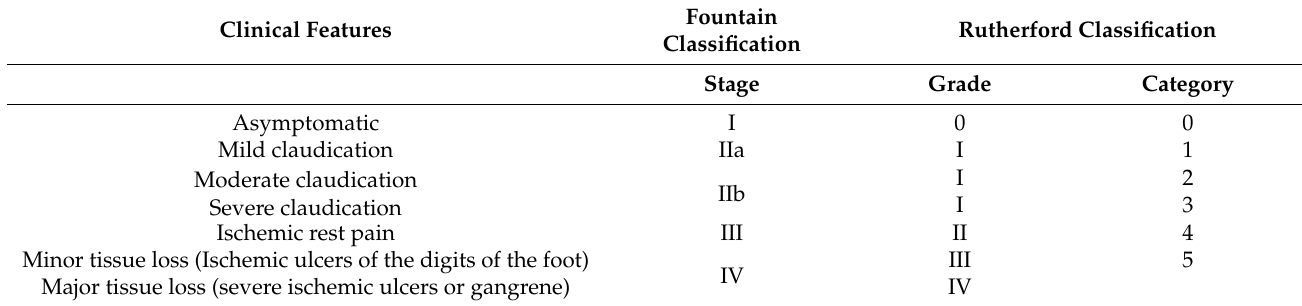
Table 2. Classification of Clinical Forms of Acute and Chronic Limb Ischemia